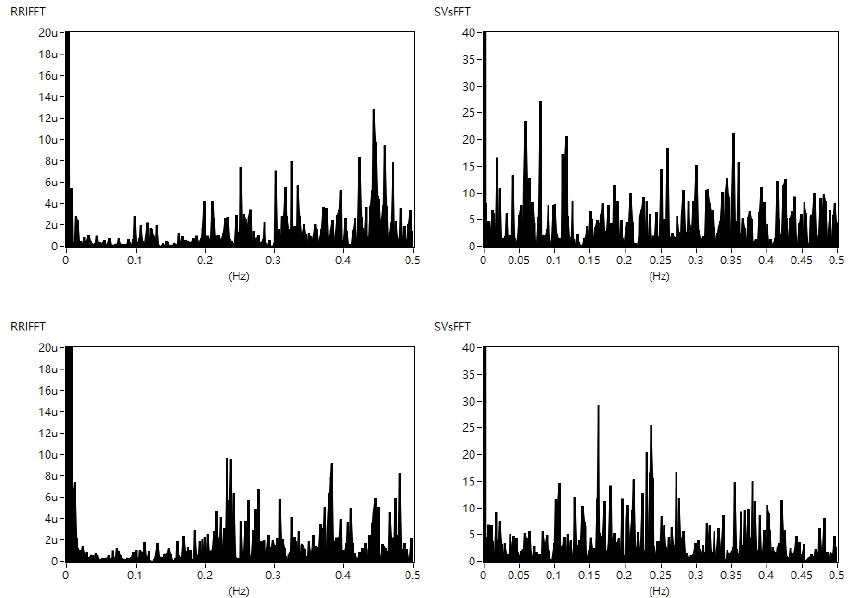
Figure 6. The frequency-domain of RR interval ( left ) and SV series ( right ) for patient #9 in the sixth stage ( upper ) and the seventh (ACP) stage ( lower ).